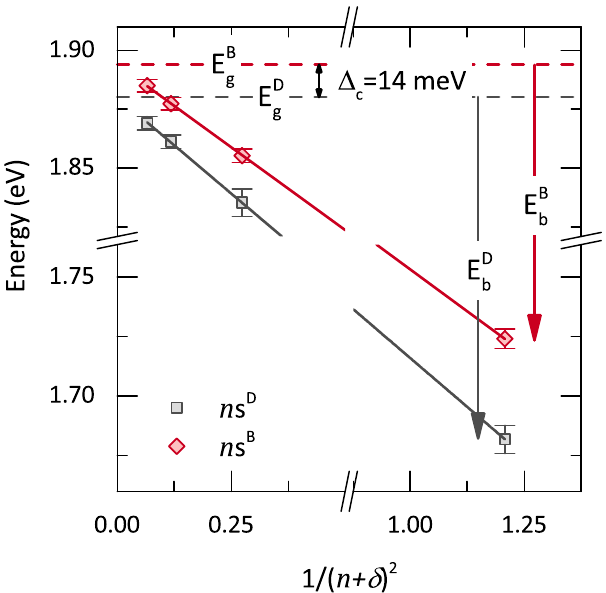
Fig. 4 Dark and bright excitonic Rydberg series. Experimentally obtained transition energies for the bright (red diamonds, n s B ) and dark (gray squares, n s D ) exciton s-series as a function of 1 = n þ δ ð Þ 2 , where δ ¼ (cid:3) 0 : 09. The error bars represent the line widths of the observed emission lines. The solid red and gray lines represent fi ts to the data with the model described in the text. The dashed red and gray lines denote the ¼ 1 : 880 eV) and bright ( E B ¼ 1 : 894 eV) excitons, bandgaps for dark ( E D g g while the red and gray arrows show the binding energies of bright (cid:1) (cid:3) ¼ 171 meV) and dark E D ¼ 198 meV ( E B excitons, respectively. The b b conduction band splitting ( Δ c ¼ 14 meV) is also